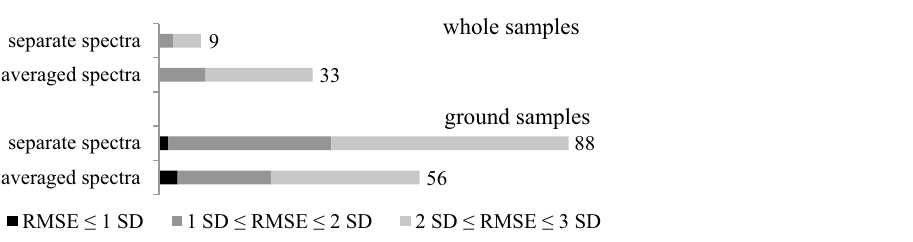
Figure 2. Number of models obtained with all three spectra or averaged spectra from whole and ground samples. The numbers next to the columns represent the total number of obtained useful